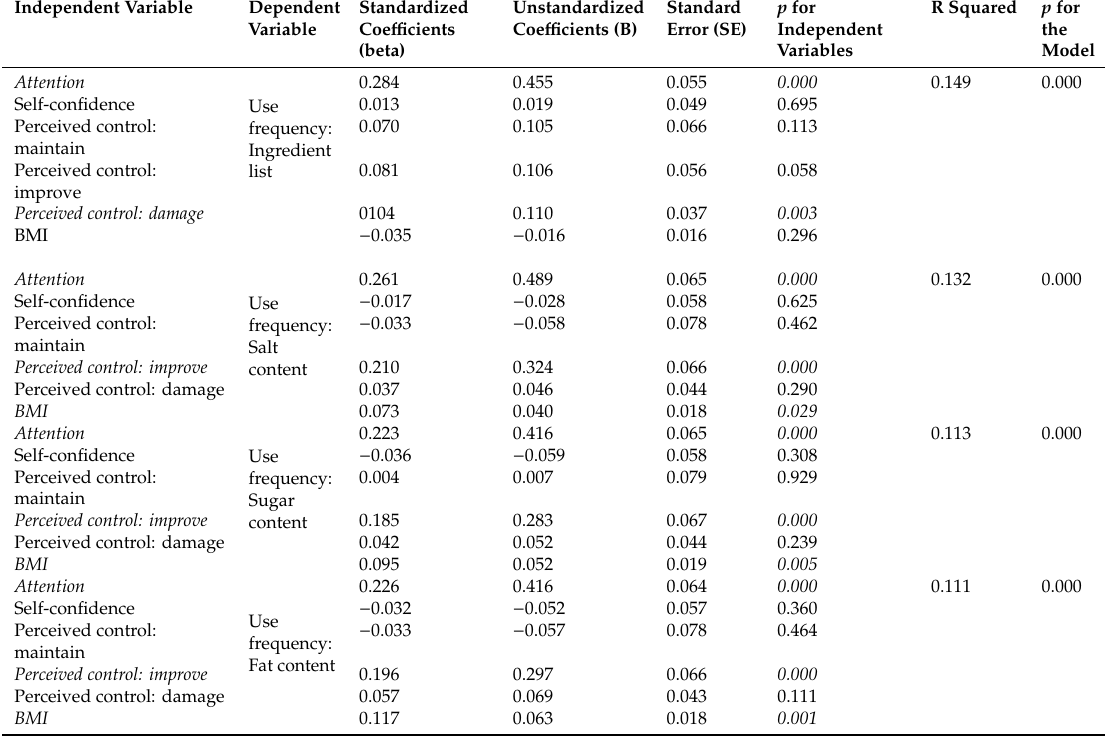
Table 8. Results of standard linear regression